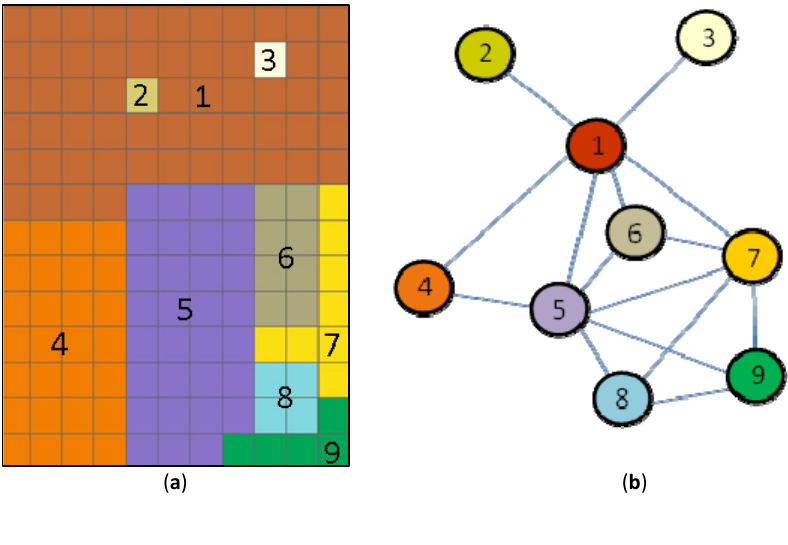
3. ( a ) Synthetic image formed by nine regions and fifteen edges; and ( b ) corresponding region adjacency graph (RAG).